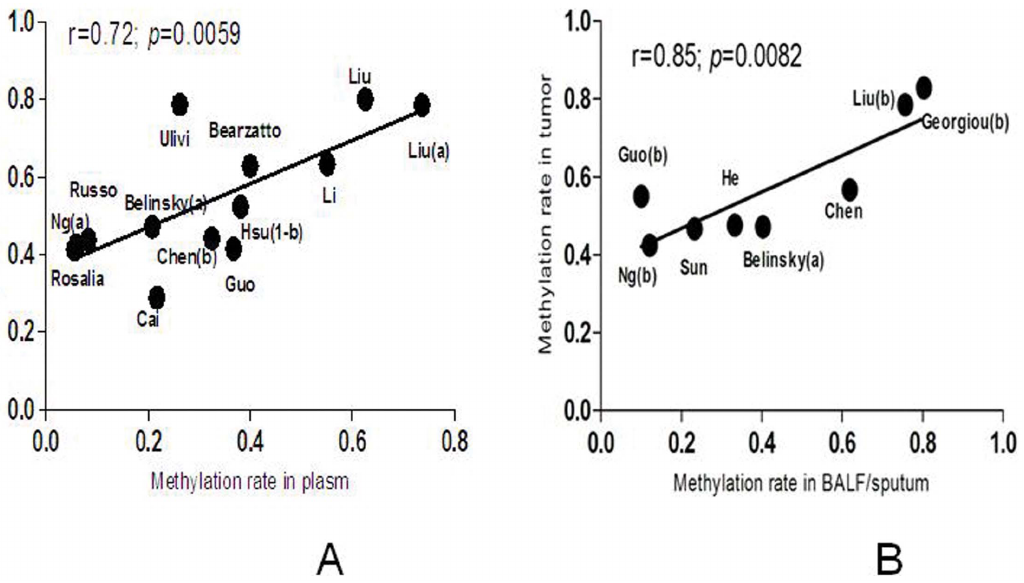
Figure 6. Begg’s funnel plot for assessment of publication bias. Each hollow circle represents a separate study for the indicated association. The area of the hollow circle reflects the weight (inverse of the variance). Horizontal line stands for the mean magnitude of the effect.